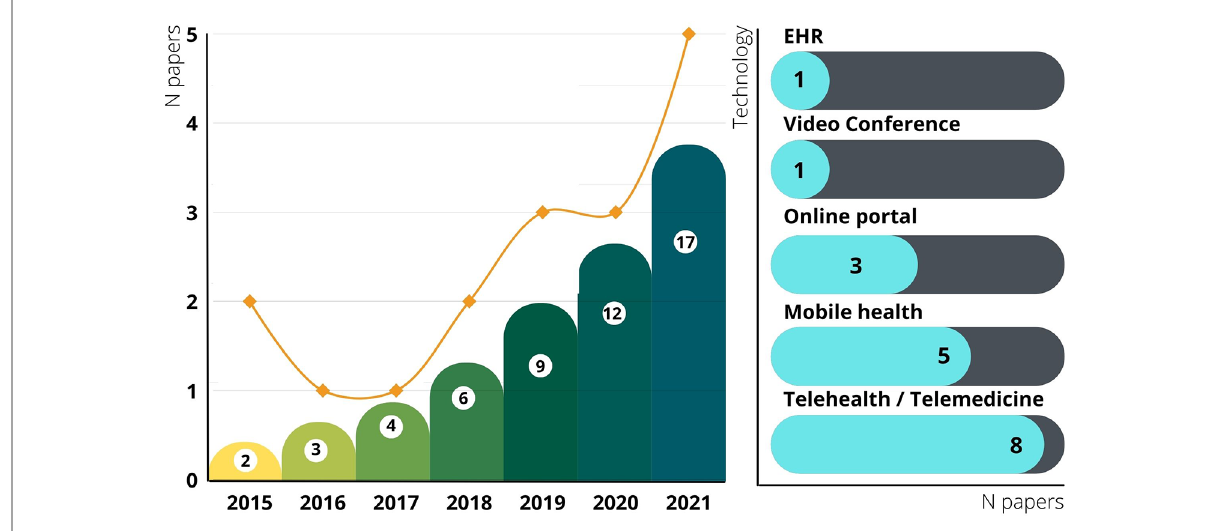
FIGURE 3 Evolution over time of the publications related to CMC and the type of technology